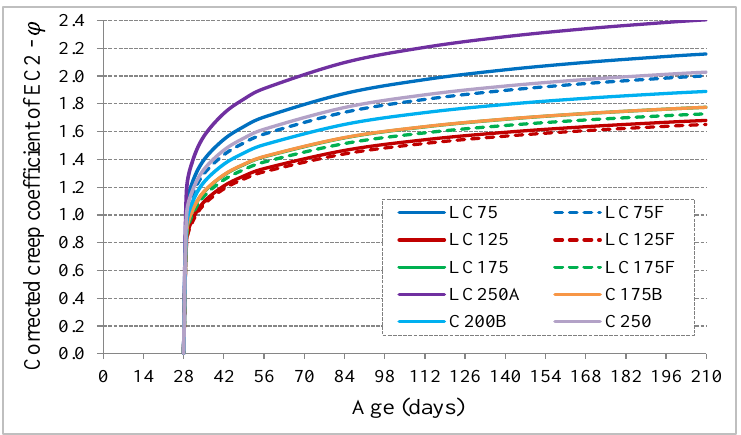
Figure 11. Evolution with age of corrected creep coefficient of EC2.